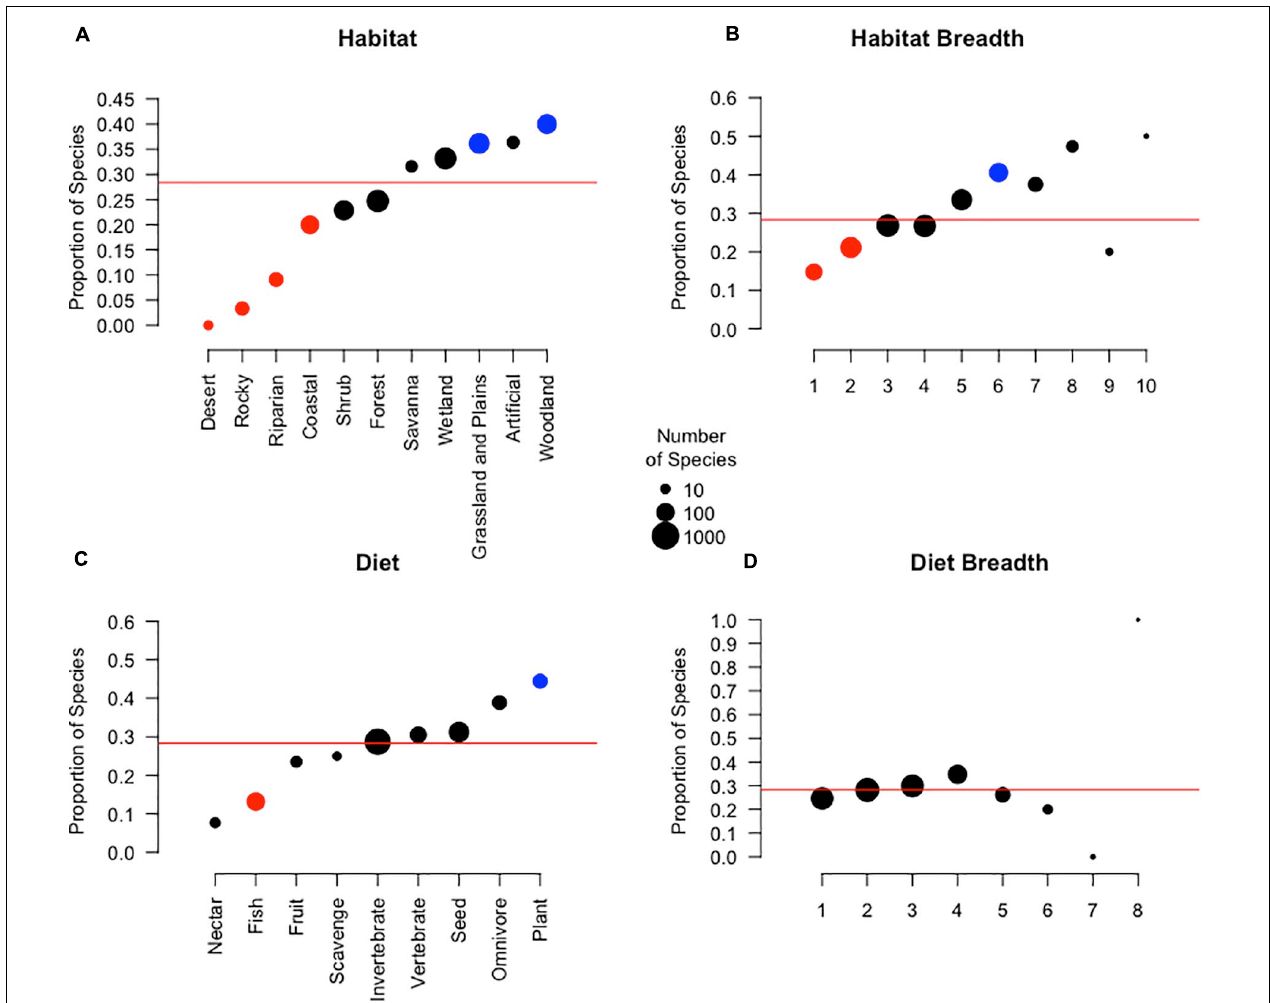
FIGURE 2 | The proportion of species that utilize temporary primary croplands by primary habitat (A) , habitat breadth (B) , primary diet (C) , and diet breadth (D) . Point size indicates the total number of species within a category. Color represents the proportion of species within each group associated with cropland compared to the average association for migratory birds overall, shown as a red line (28.3%): blue indicates a significantly higher than average proportion, red indicates a significantly lower than average proportion, and black indicates non-significant